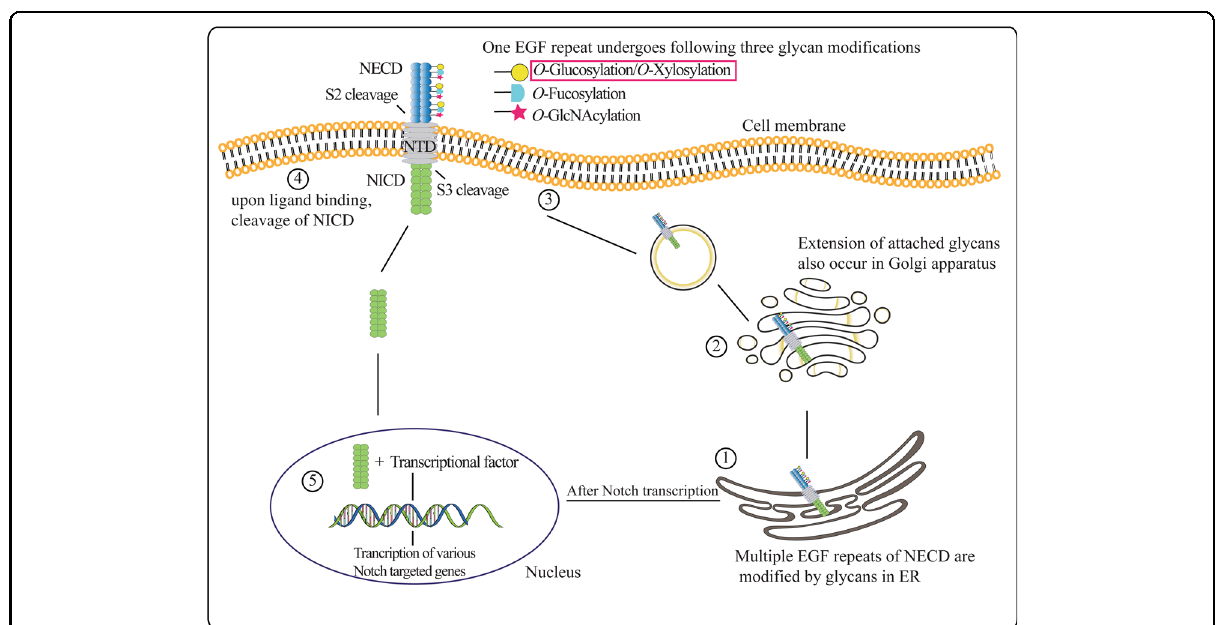
Fig. 2 A representation of Notch structure, modi fi cation, and signaling. Notch receptor involved in several biological processes has three domains: NECD, NTD, and NICD. The NECD comprises a set of EGF-like repeats which undergo glycosylation. (1) The properly folded EGF repeats of NECD are modi fi ed with glycans added by glycan-speci fi c enzymes and (2) these glycans are further extended in the Golgi apparatus or even also in the ER. (3) Sugar decorated Notch is transported to the cell membrane through membrane-bound vesicles. (4) After ligand (Delta, Jagged) binding, the ADAM proteases and γ -secretases execute Notch S2 and S3 cleavage, respectively, ultimately releasing the NICD that moves to the nucleus (5) where it binds the Notch pathway effector proteins to induce the expression of Notch target